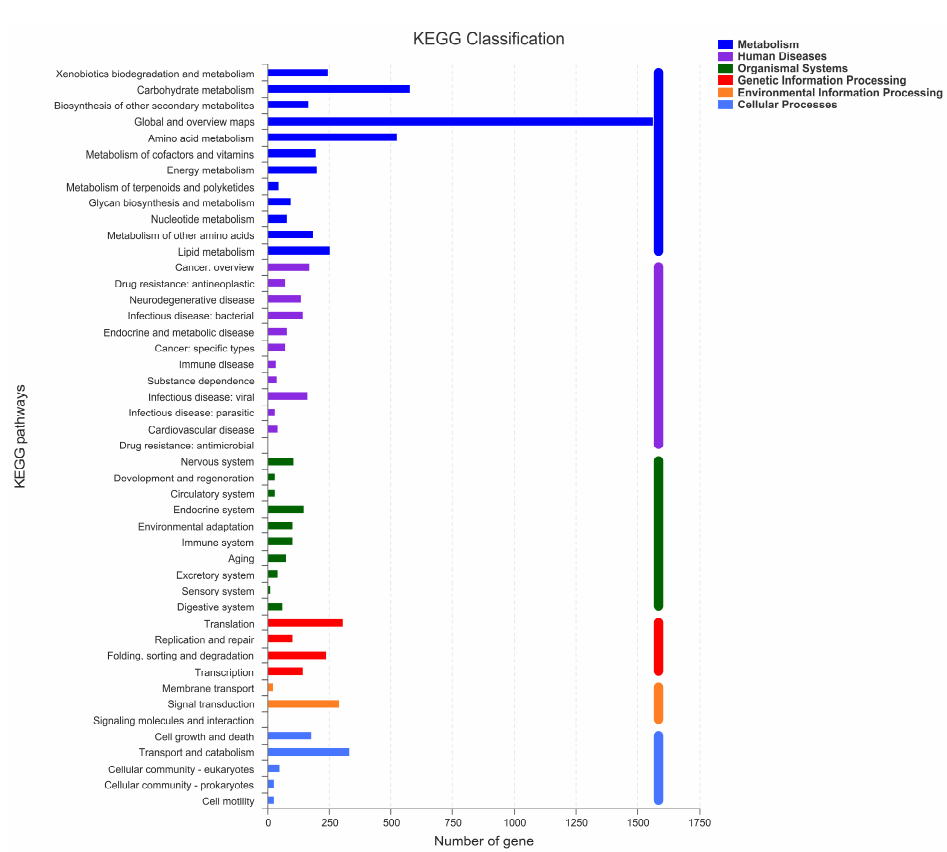
Figure 5. Kyoto Encyclopedia of Genes and Genomes (KEGG) analysis of D. alcacerensis CT-6 genes encoding the proteins.